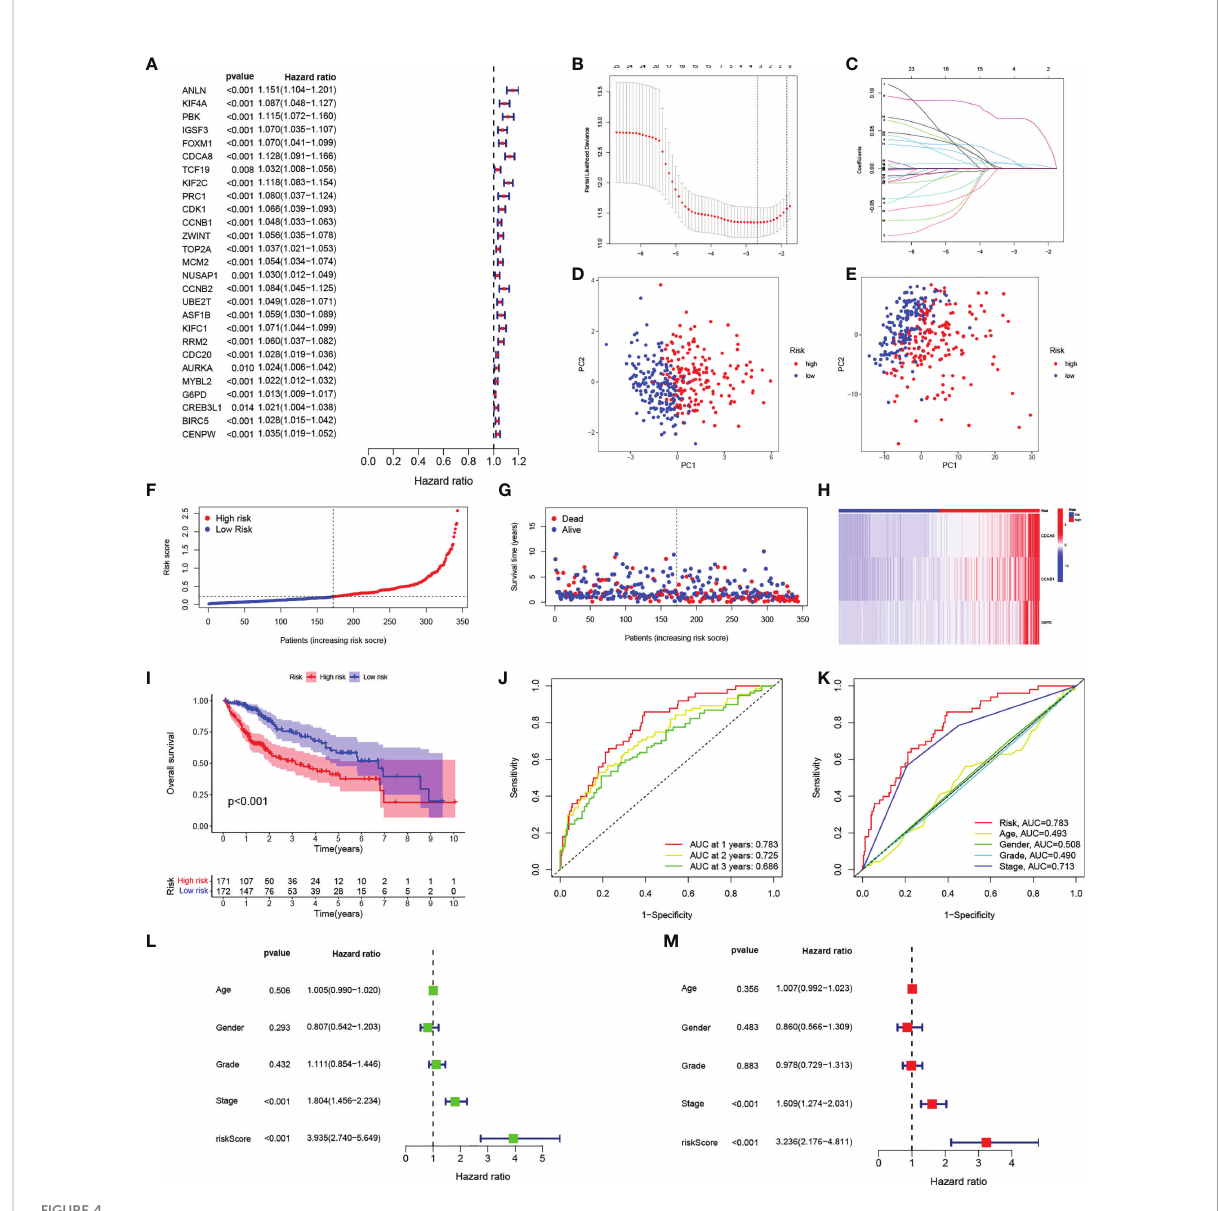
FIGURE 4 Construction of the risk signature. (A) Forest plot of univariate Cox regression results for the 27 DEGs. (B) Cross-validation for selection of tuning parameters in LASSO regression. (C) LASSO coef fi cient pro fi les of candidate DEGs. (D) PCA of samples from high- and low-risk groups. (E) PCA of DEGs in the high- and low-risk groups. (F) Risk score distribution of HCC patients in the TCGA cohort. (G) Scatter plot of survival status of HCC patients in the TCGA cohort. (H) Heatmap of the expression of the three signature genes in high- and low-risk populations in the TCGA cohort. (I) K-M curves of OS in HCC patients in the risk score-based TCGA cohort. (J) ROC curves of prognostic signatures for one, two, and three years in the TCGA cohort. (K) ROC curves of prognostic signatures and other clinicopathological features for one year in the TCGA cohort. (L, M) Forest plots of univariate and multivariate Cox regression analyses of prognostic signatures and clinical features in the TCGA cohort. DEGs, differentially expressed genes; LASSO, least absolute shrinkage and selection operator; PCA, principal component analysis; HCC, hepatocellular carcinoma; TCGA, the Cancer Genome Atlas; K-M, Kaplan-Meier; OS, overall survival; ROC, receiver operating